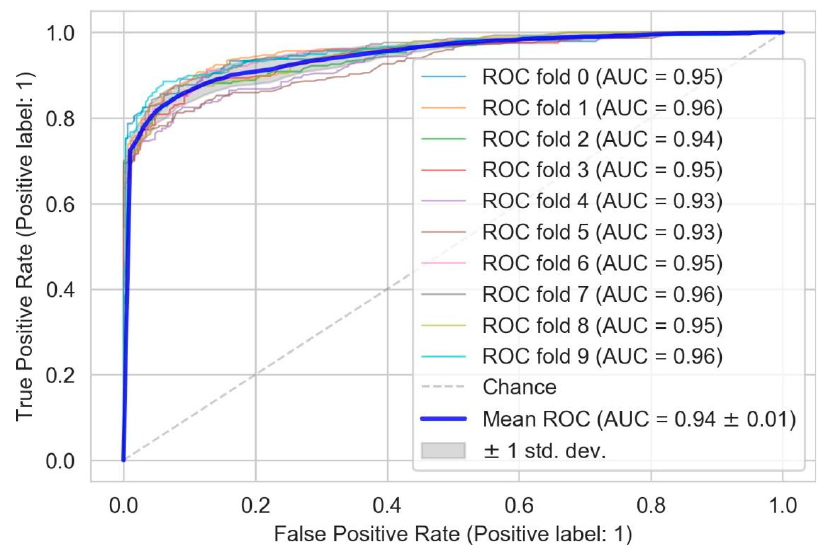
Figure 11. Ten-fold cross-validation ROC curve for the Extra Trees classifier